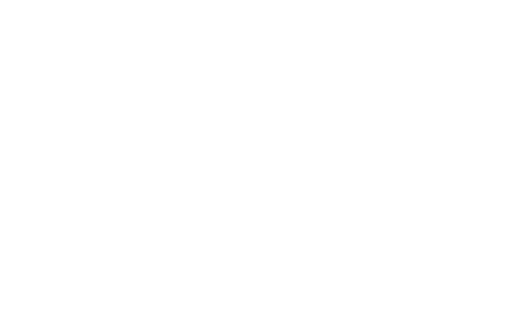
0.5 Table 2. Nu x Re − x numerical values for versus various parameters.